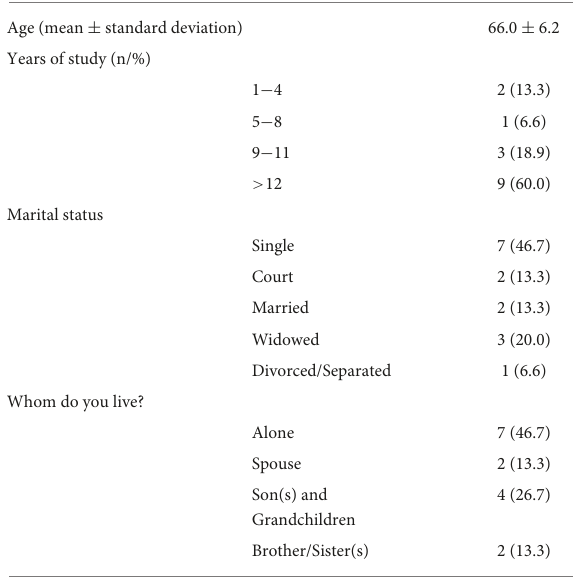
TABLE 1 Sociodemographic characteristics of participants ( n =